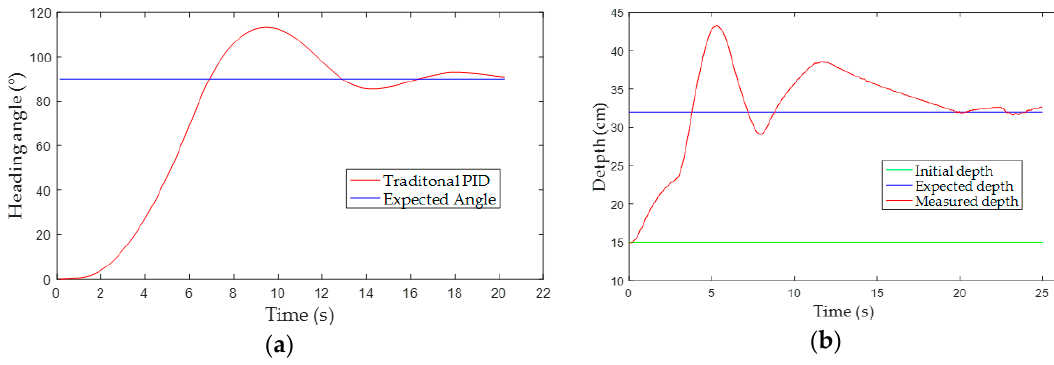
Figure 25. ( a ) Experimental results for heading angle control; ( b ) experimental results for depth control.